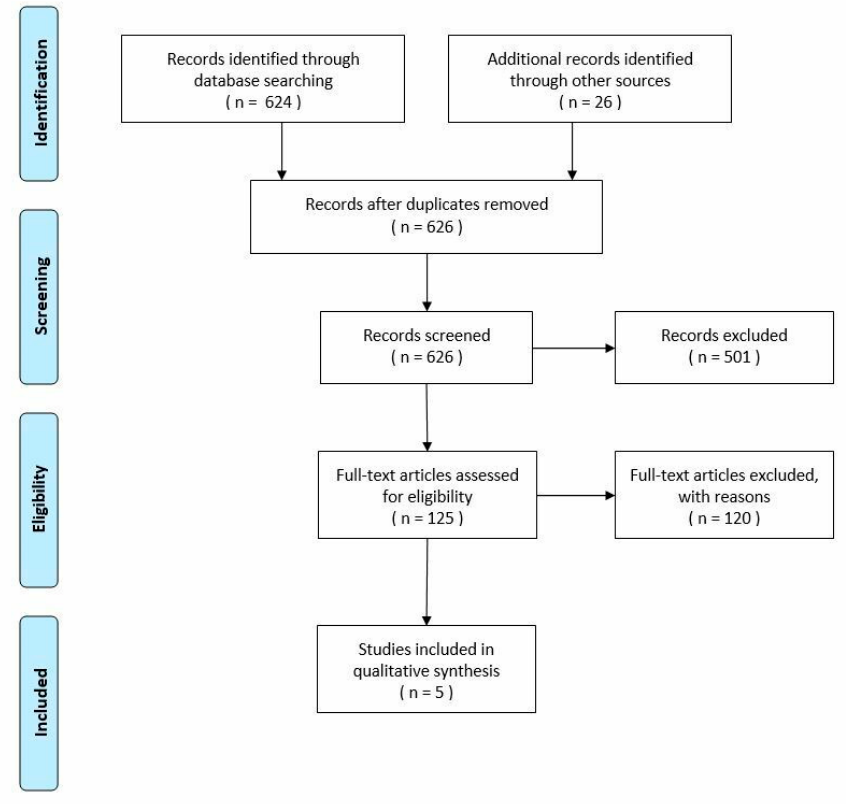
Figure 1. Dimensions and features investigated in the qualitative analysis PRISMA flow chart.